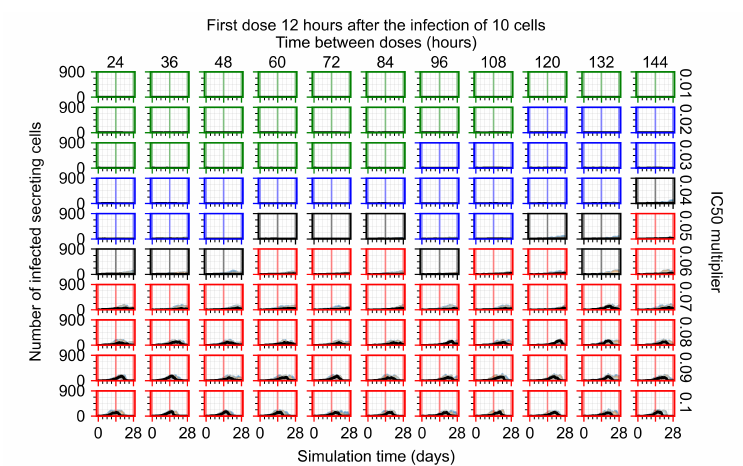
Figure A15. Infected (eclipse phase) population.